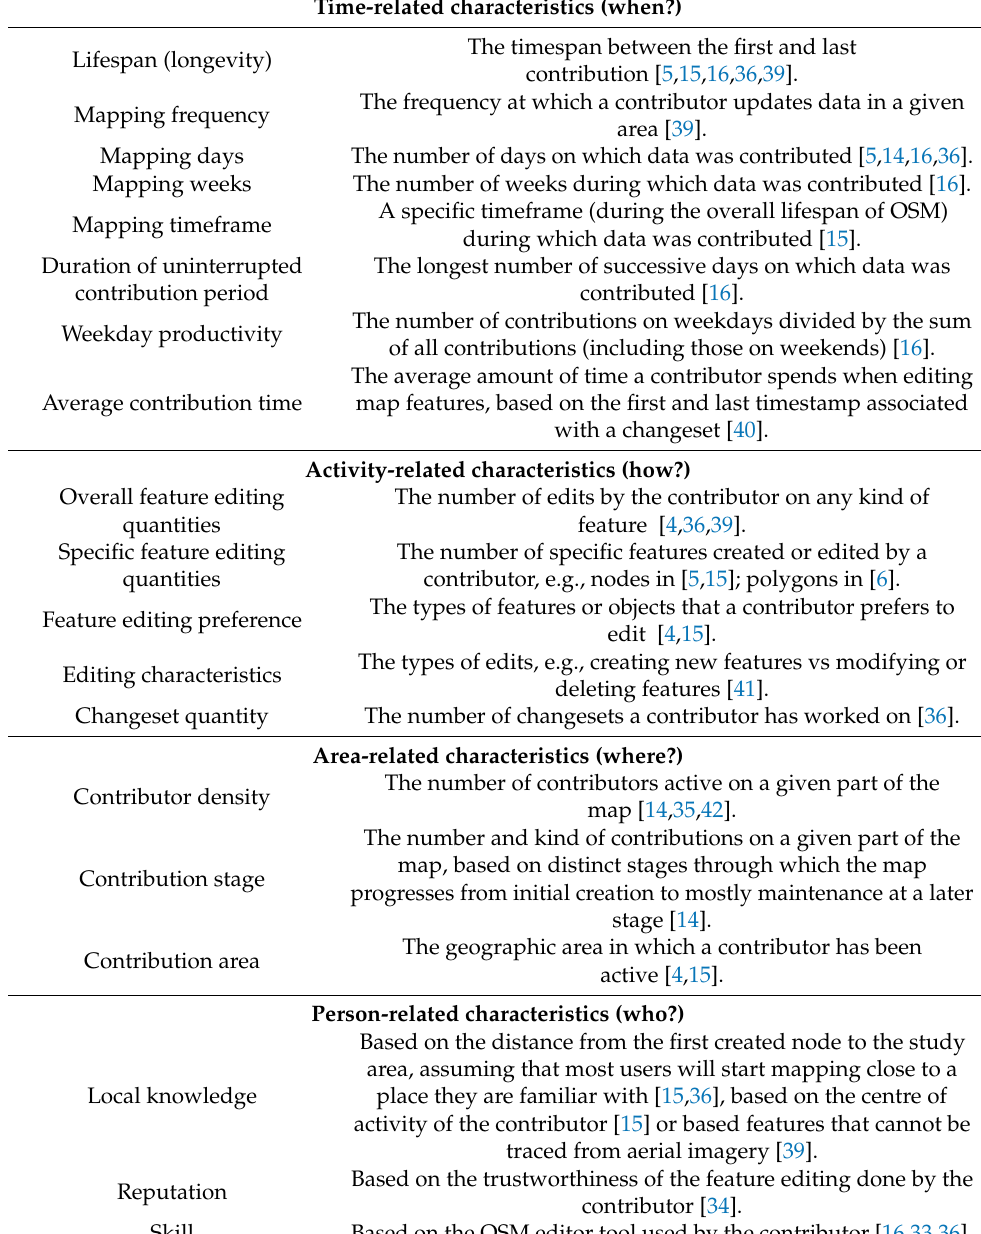
Table 1. Contributor-focused